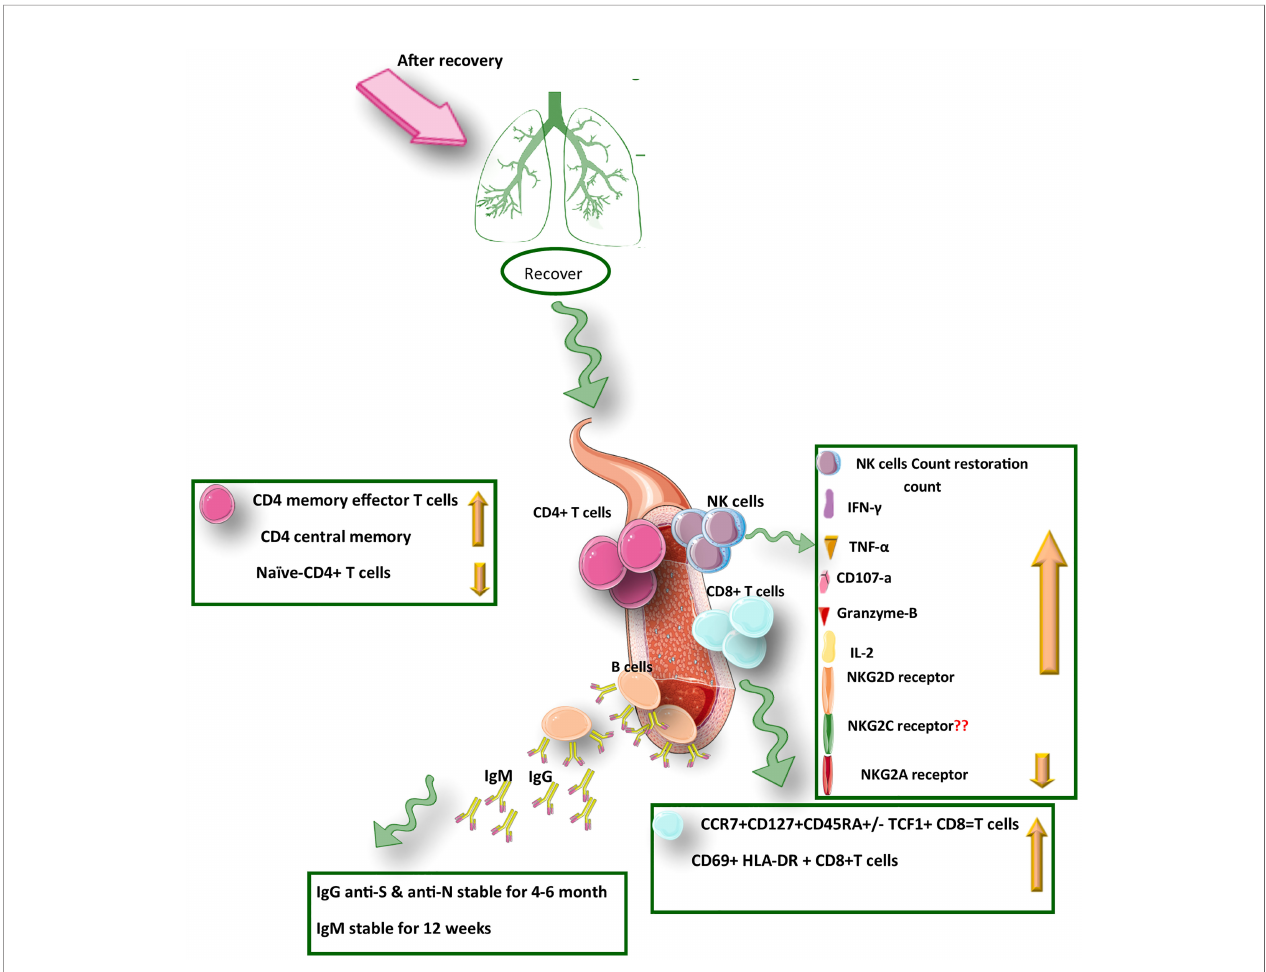
FIGURE 2 | A summary of the protective immunity against COVID-19 infection after recovery from SARS-CoV-2